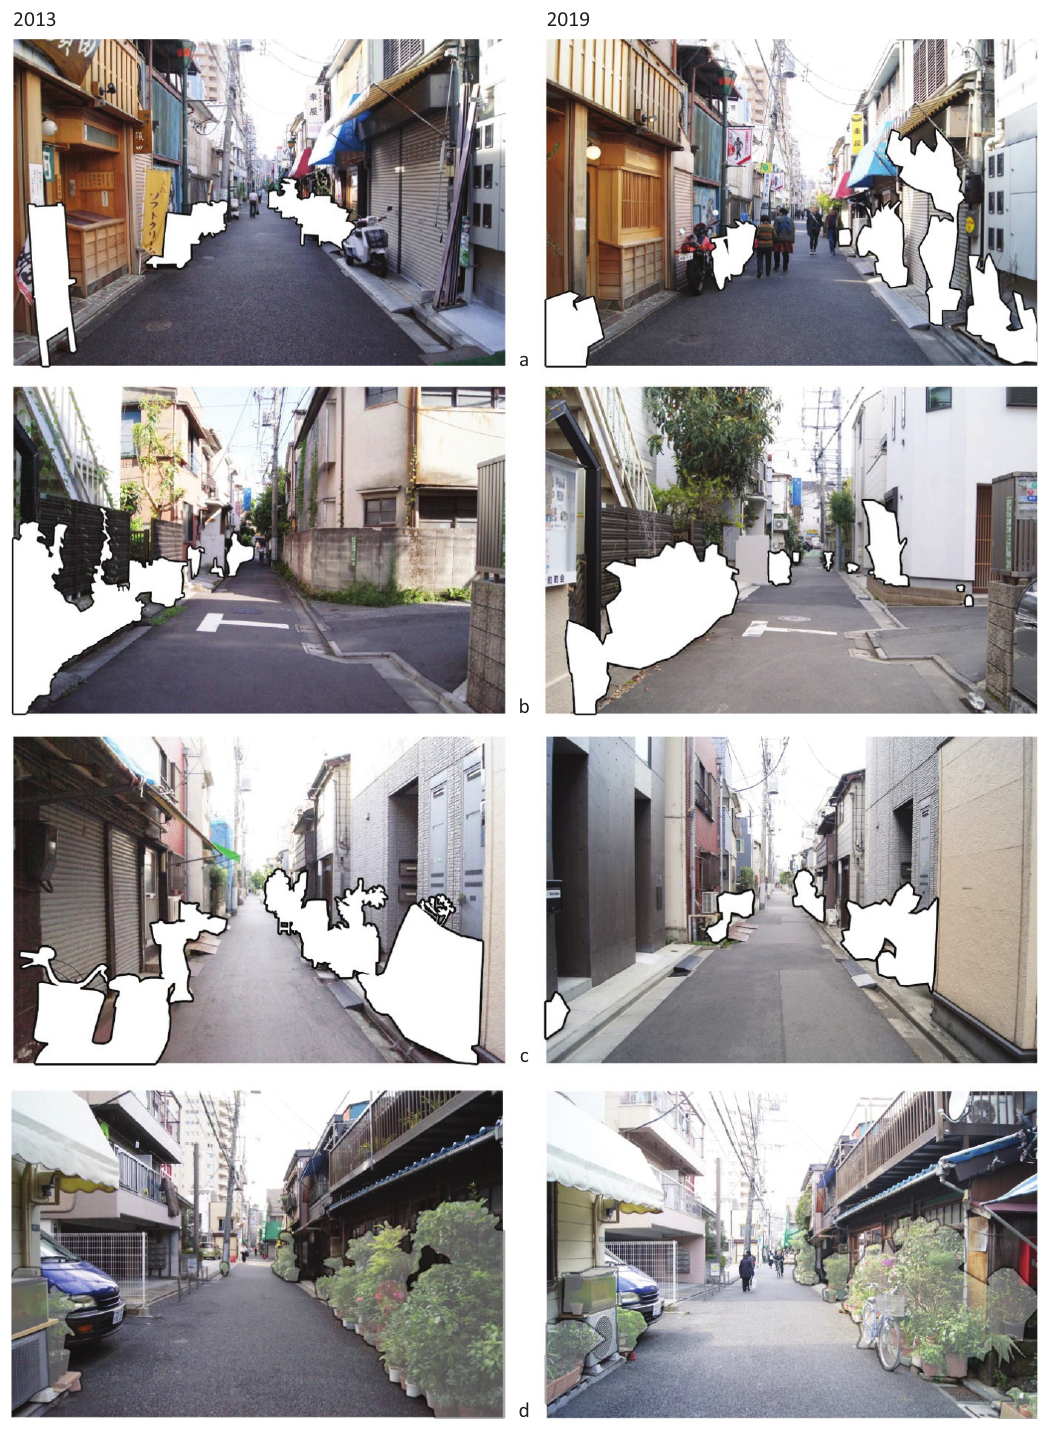
Figure 5. Comparative photographic